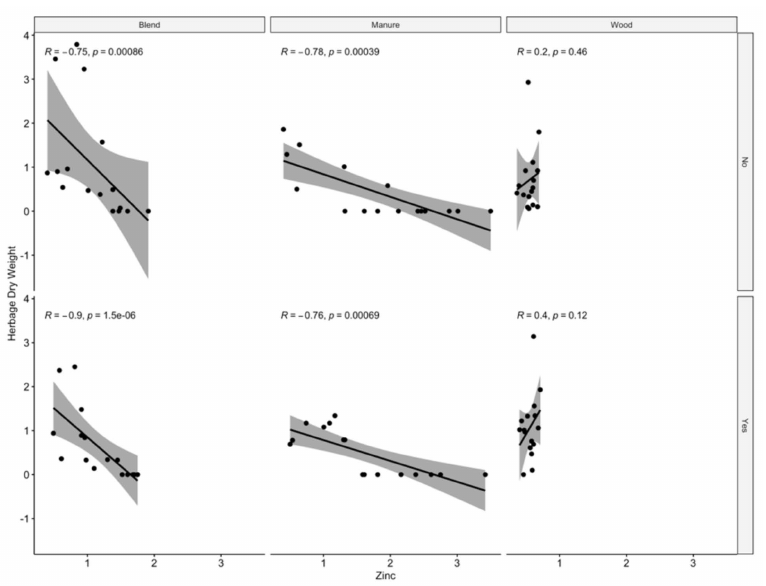
Figure 2. Herbage dry weight (H-DW) (g) × Zn (ppm), Spearman’s correlation for T. incarnatum by BC type and saturation (yes for